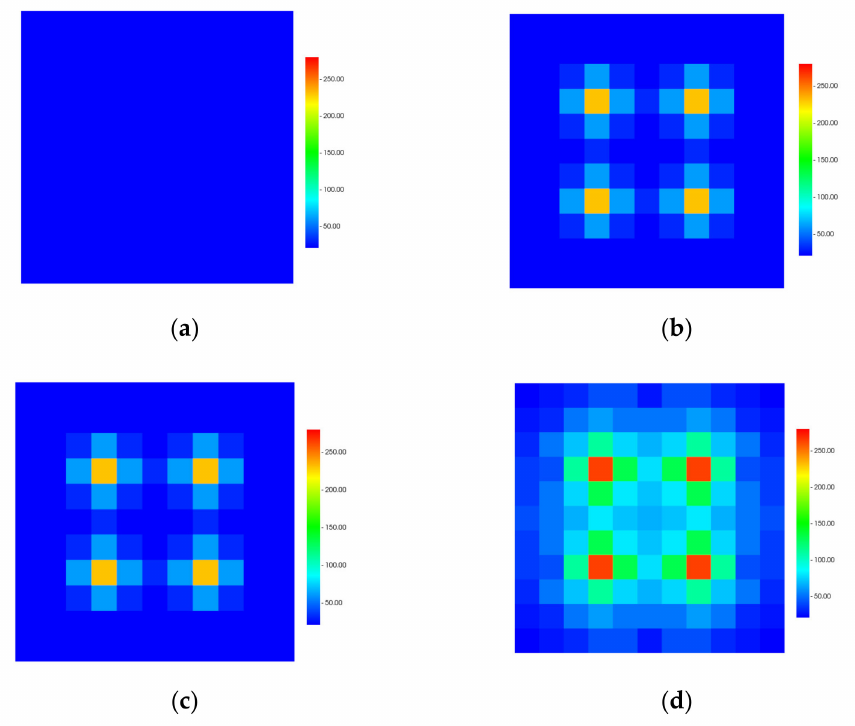
Figure 6. Reservoir temperature profiles calculated by CMG. ( a ) The 0.001th day; ( b ) the 10th day; ( c ) the 30th day; ( d ) the 200th